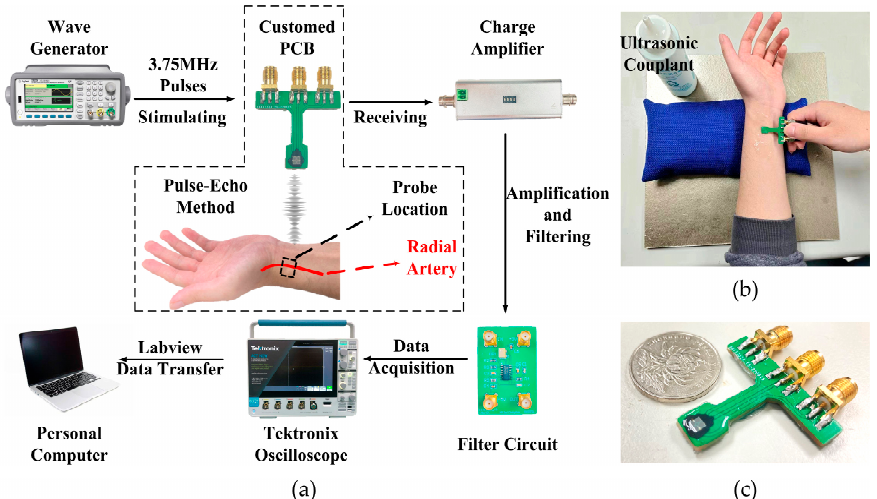
Figure 8. ( a ) Schematic of the pulse-echo detection signal transfer system. ( b ) Radial artery moni- toring (corresponding to the dashed box in ( a )). ( c ) Customized PCB for PMUT package and size comparison with a coin.